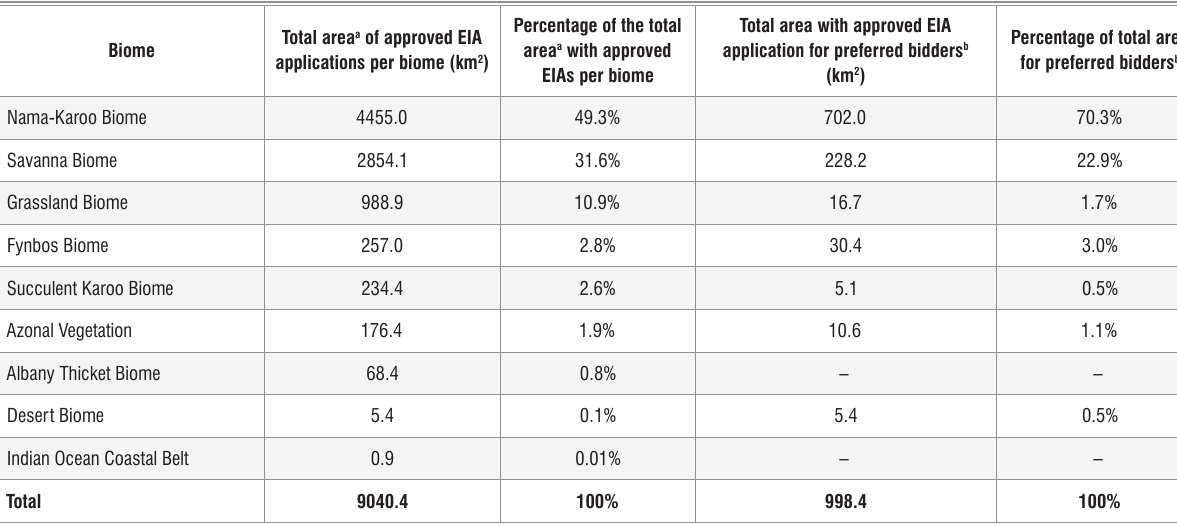
a Total area for all approved solar power developments throughout Rounds 1–3 of the REIPPPP. Not all of these projects continued on toward construction and